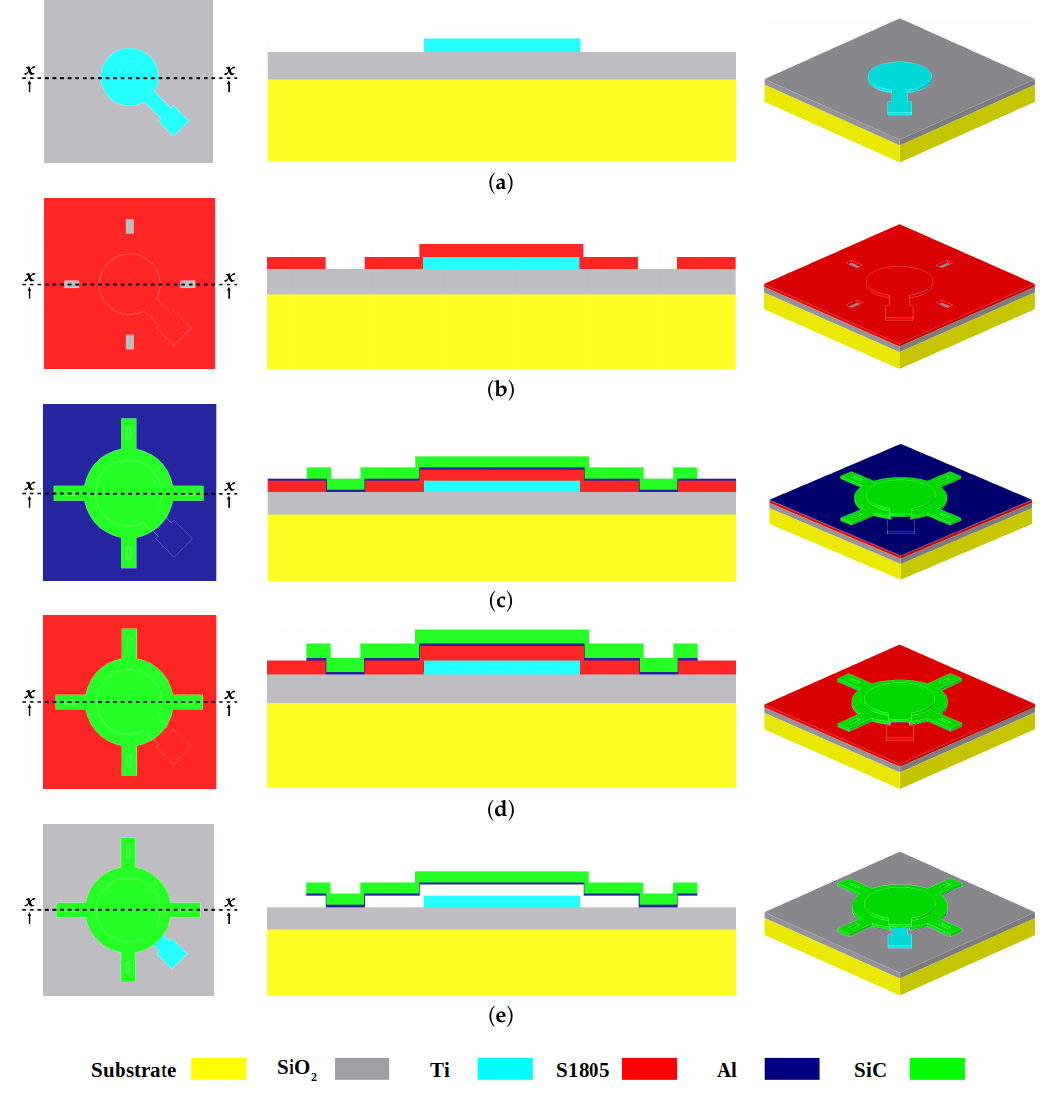
Figure 1. Top-view (left), cross section x − x (middle), and 3D (right) views for the different steps of the proposed fabrication process flow: ( a ) depositing and patterning the lower metal (Ti); ( b ) spinning the sacrificial layer and defining the anchors; ( c ) depositing (SiC + Al) and patterning the SiC structural layer; ( d ) etching the upper metal (Al); ( e ) releasing the structure in ultrasonic bath + critical point dryer